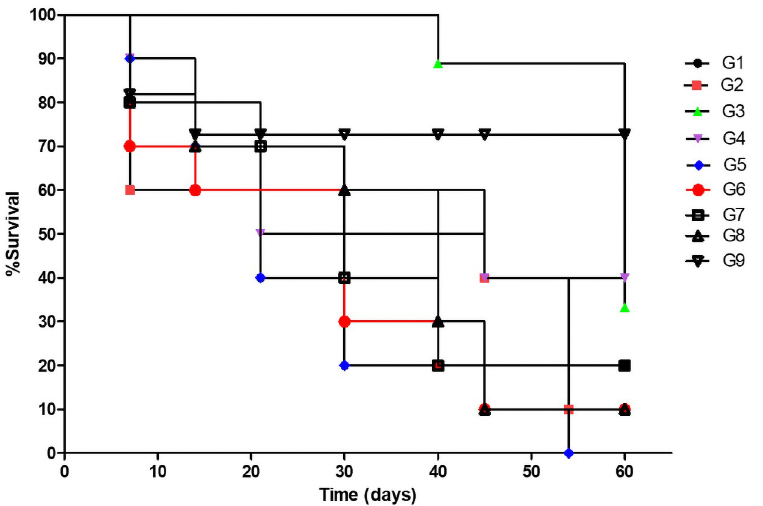
Fig 6. Survival curve of the animals immunized with the different vaccine formulations after challenge with the virulent strain CPNS (10 7 CFU/mL) of C . pseudotuberculosis . Each twice-vaccinated group was composed of 12 animals and survival was monitored for 60 days after challenge. G1—inoculated with PBS; G2—inoculated with Saponin; G3—inoculated with Peptide 1 + saponin; G4—inoculated Peptide 2 + saponin and G5—inoculated with Peptide 3 + saponin; G6—inoculated with Peptide 4 + saponin; G7—inoculated with Peptide 5 + saponin; G8— inoculated with Peptide 6 + saponin and G9—inoculated with rCP40 + saponin. Statistical analysis with test Fisher P Value > 0.0076 showing no statistical difference between groups. Statistical analyses were carried out with GraphPad Prism 8.03 software systems (GraphPad Prism Software).